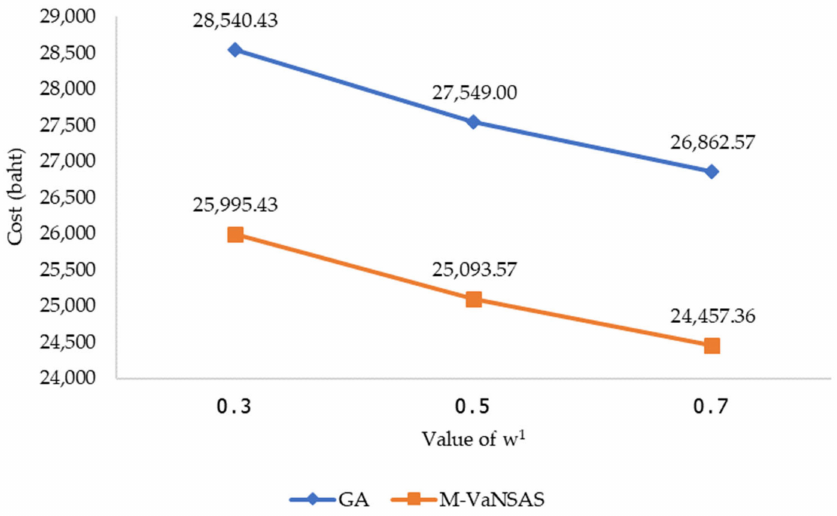
Figure 4. Effect of weight w 1 on the total cost given by different solution